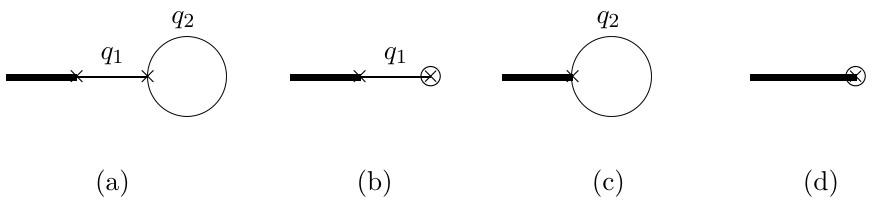
Figure 2 . The four Feynman diagrams that contribute to the annulus one-point amplitude. The thick line denotes a closed string, while thin lines denote open strings. The (cid:2) denotes a vertex on the upper half plane, whereas b denotes a vertex on the annulus. The variables q 1 and q 2 are the plumbing fixture variables associated with the corresponding propagators. Figure reproduced from